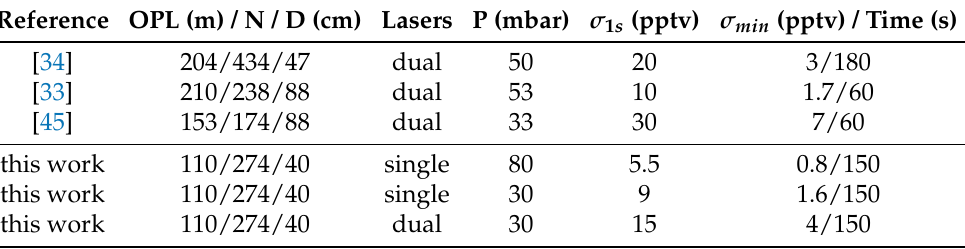
Table 1. Comparison of reported precision for NO 2 measurements by QCLAS and TDLAS. OPL, optical path length; N, number of passes of the laser beam in the MPC; D, distance between the MPC mirrors; P, pressure in the MPC; σ 1 s , Allan deviation at 1s resolution; σ min , minimum Allan deviation; time, integration time corresponding to σ min